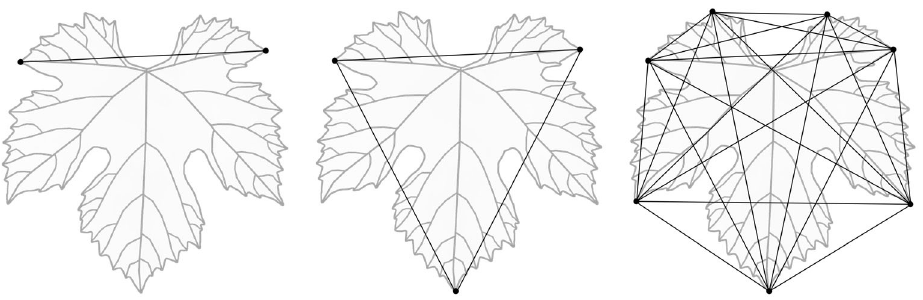
Figure 5. Calculated linear traits according to two, three and seven morphometric landmarks along the leaf boundary. the leaf